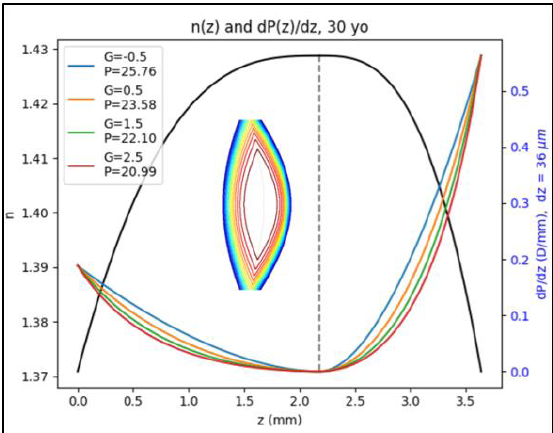
Fig. 1. Axial index distribution n and power differential d P /d z for a 30-year-old model. The label specifies the curvature gradient index G and the resulting refractive power